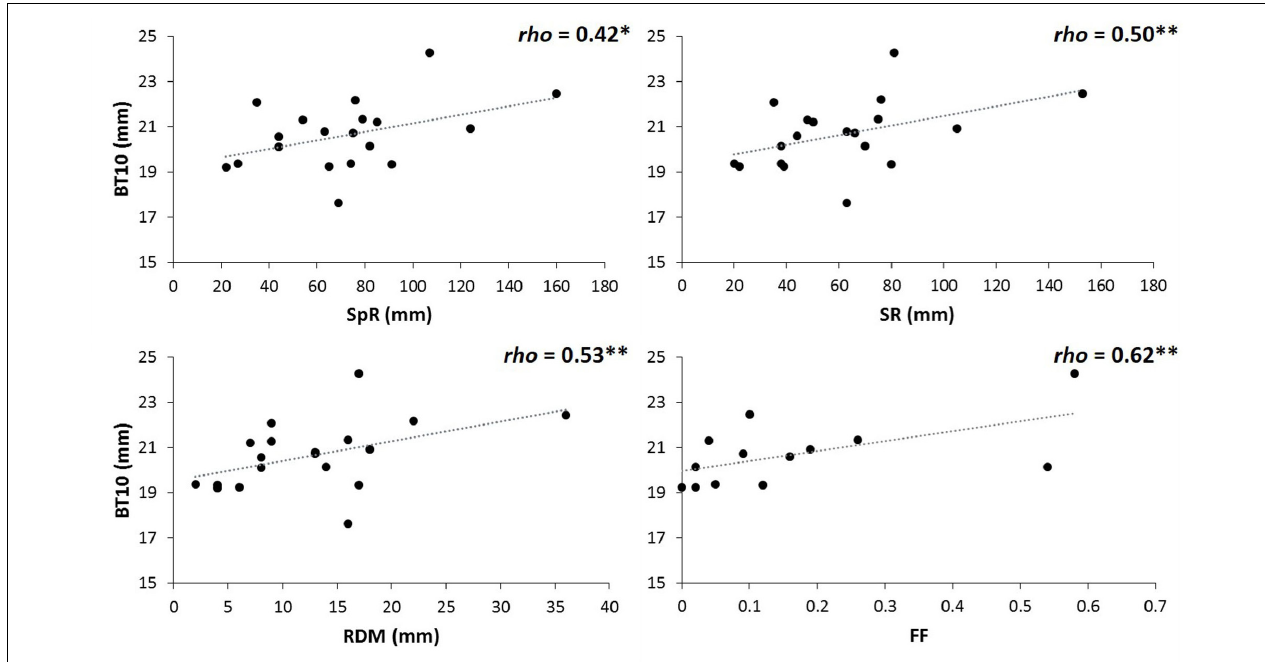
FIGURE 5 | Spearman correlations between basal bark thickness at the drier site (BT10) and spring rainfall (SpR), summer rainfall (SR), rainfall of the driest month (RDM), and fire frequency (FF). Significance for Spearman correlations at: ∗∗∗ P < 0.001, ∗∗ P < 0.01, ∗ P < 0.05, n.s. = no significant ( n = 19 populations for correlations with environmental variables; n = 13 Iberian populations for correlations with fire